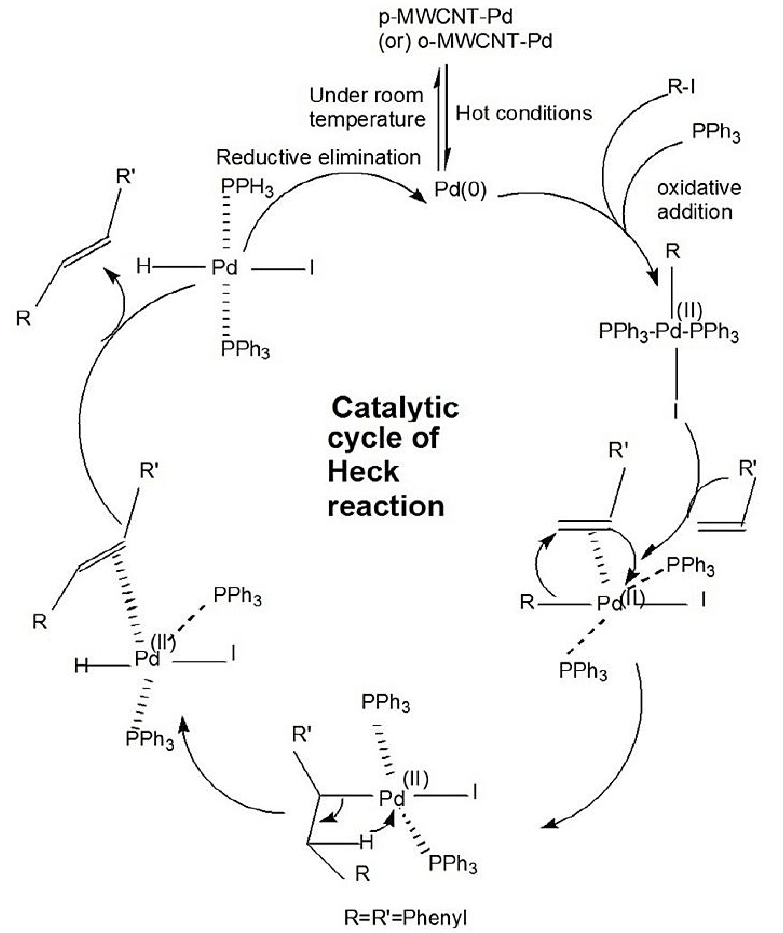
Figure 5. The role of CNT-Pd in the in the Heck reaction.